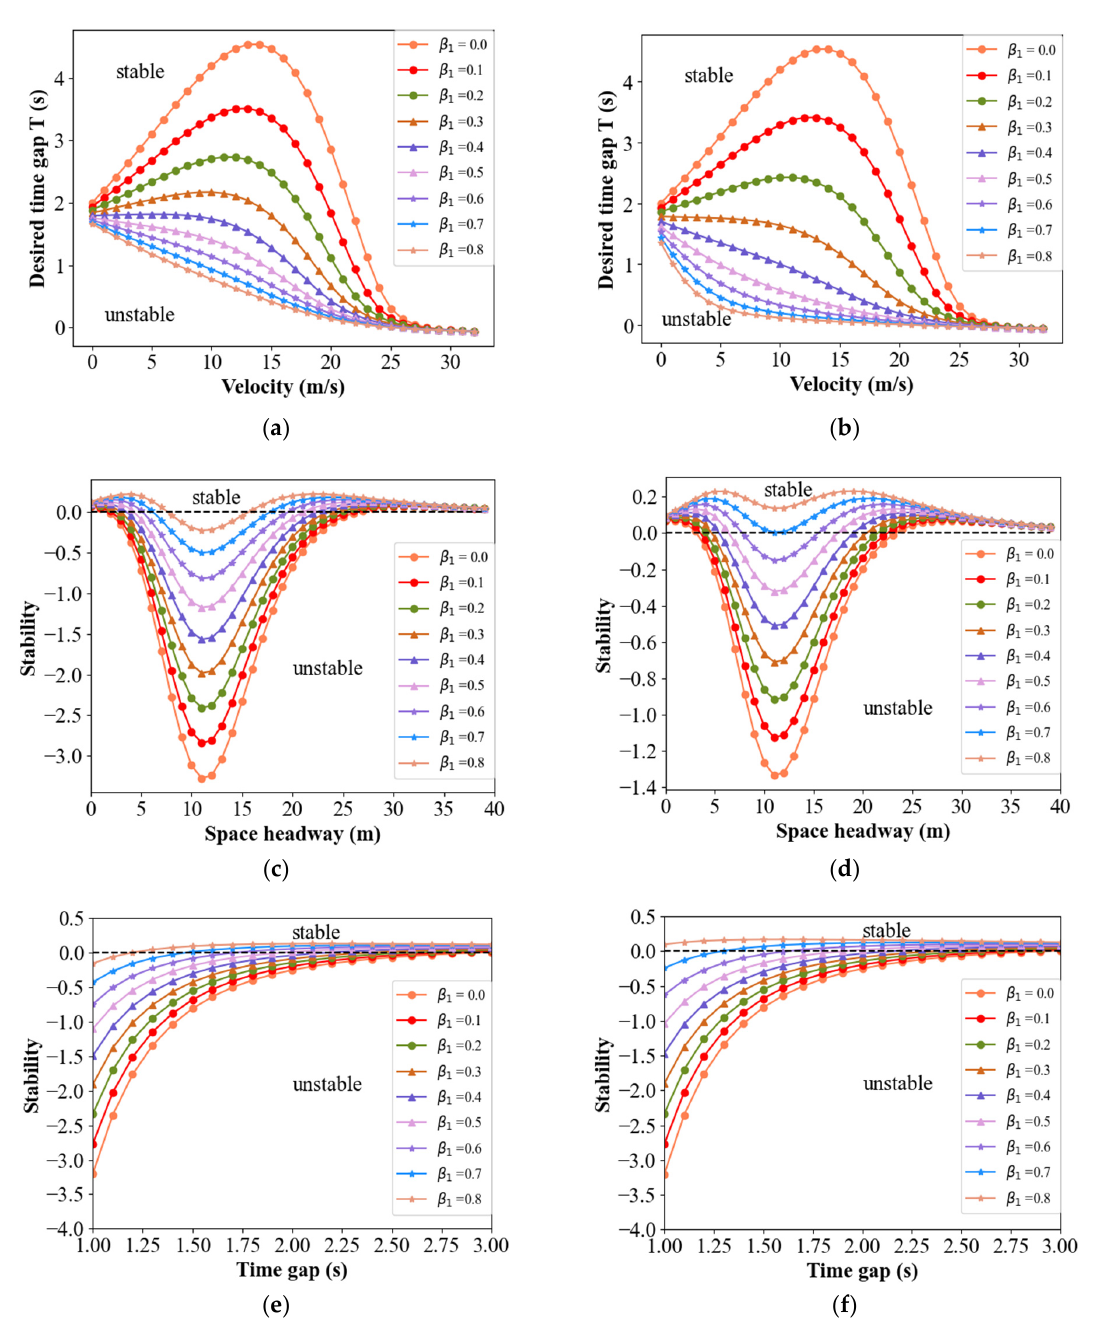
Figure 4. Relationships among the string stability of the traffic, β 1 , and the vehicle position under the DMVIS for four models. ( a ) Stability curves for 2nd vehicle in IDM under the DMVIS; ( b ) Stability curves for 8th vehicle in IDM under the DMVIS; ( c ) Stability curves for 5th vehicle in FVD under the DMVIS; ( d ) Stability curves for 5th vehicle in OV model under the DMVIS; ( e ) Stability curves for 5th vehicle in ACC model under the DMVIS; ( f ) Stability curves for 8th vehicle in ACC model under the DMVIS.